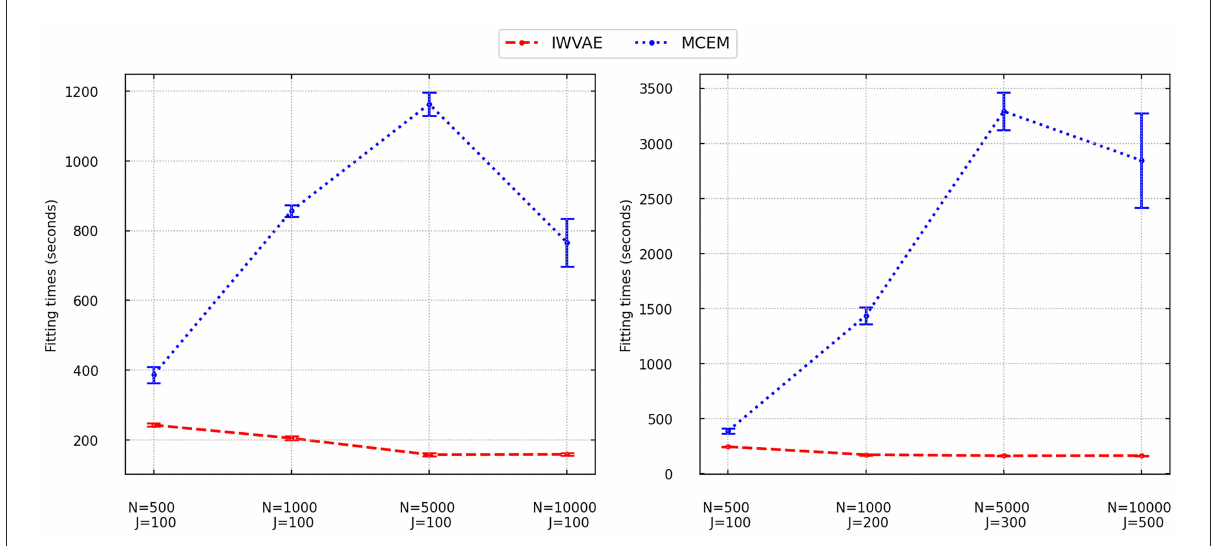
FIGURE2 Fitting times for IWVAE and MCEM with M4PL model under the single (different sample sizes N and fixed item dimension J ) and double [different ( N , J )] asymptotic regimes. Vertical bar areas mark empirical 95% intervals.